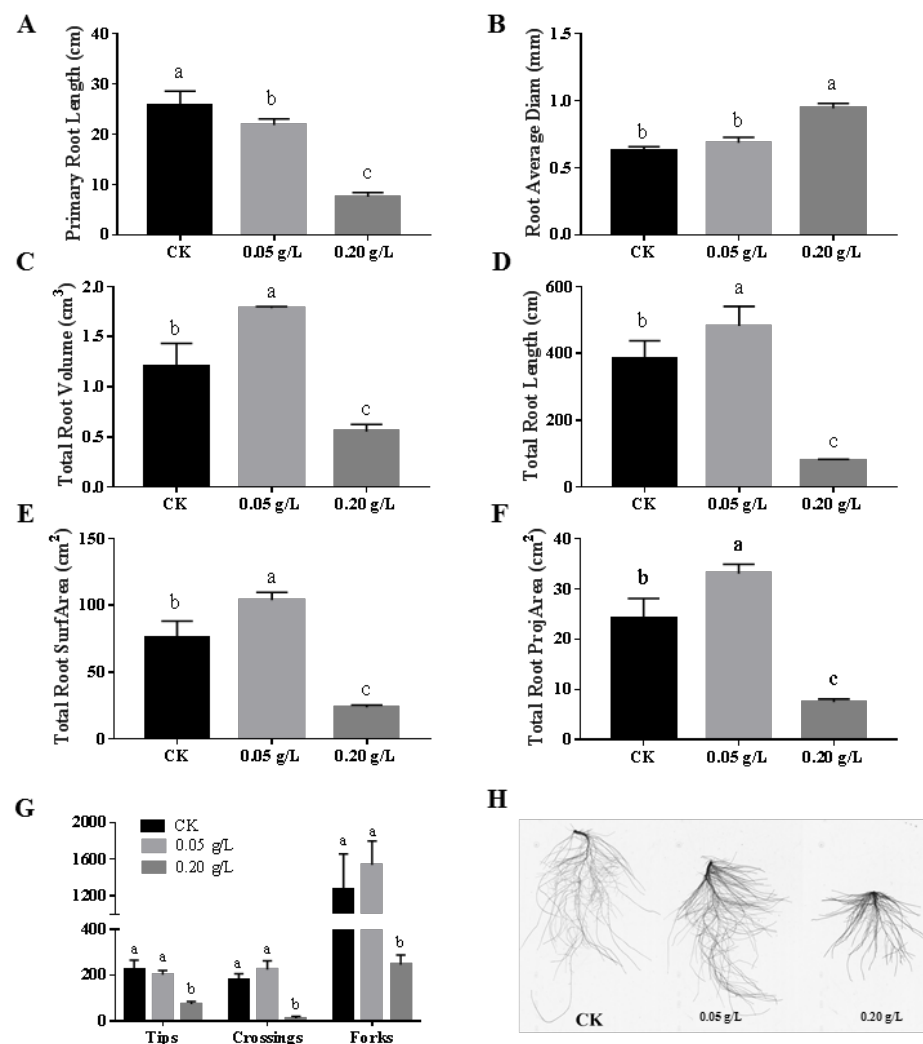
Figure 3. Effects of different concentrations of CMS on the root growth of Brassica napus . CK is a full-strength Hoagland’s solution. Two concentrations (0.05 and 0.20 g L − 1 ) of CMS were added to the Hoagland’s solution. ( A ) Primary root length; ( B ) Root average diameter; ( C ) Total root volume; ( D ) Total root length; ( E ) Total root surface area; ( F ) Total root projected area; ( G ) Root tips, forks and crossings; ( H ) Root architecture. Different letters indicate the significant differences at p < 0.05 by Duncan’s test. Data are means ± SD with four biological replicates.